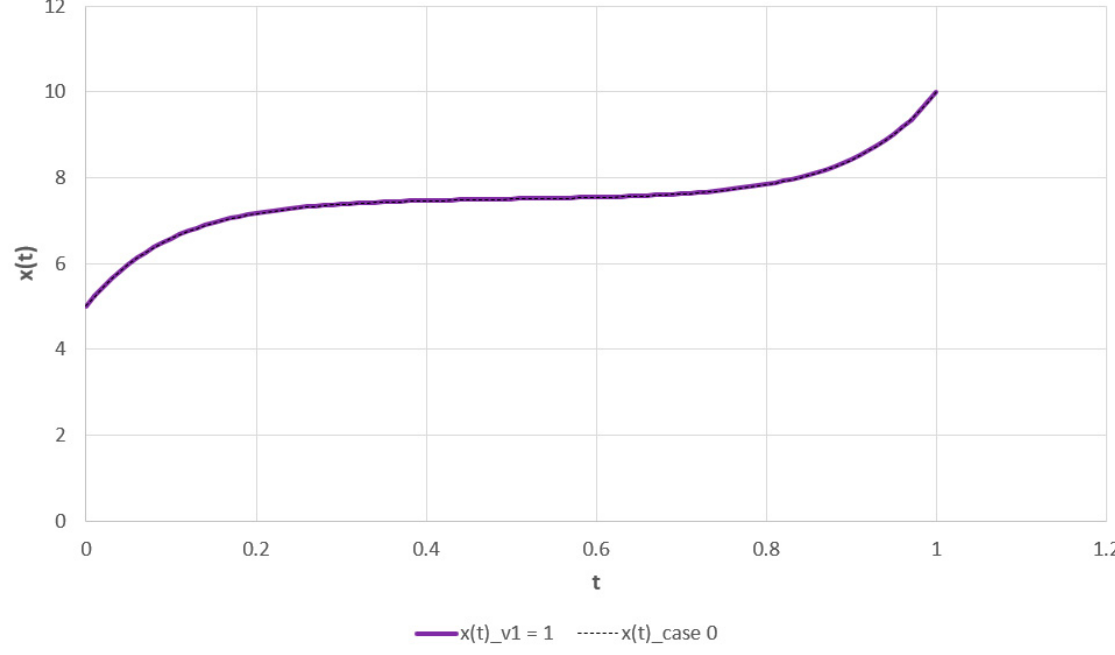
Figure 20. The optimal time path of x in Dynamic case 5.